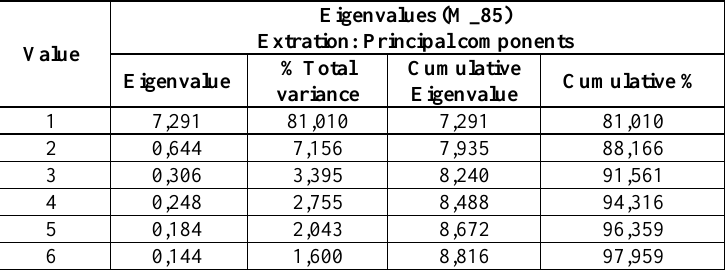
Table 1. Informativeness of main